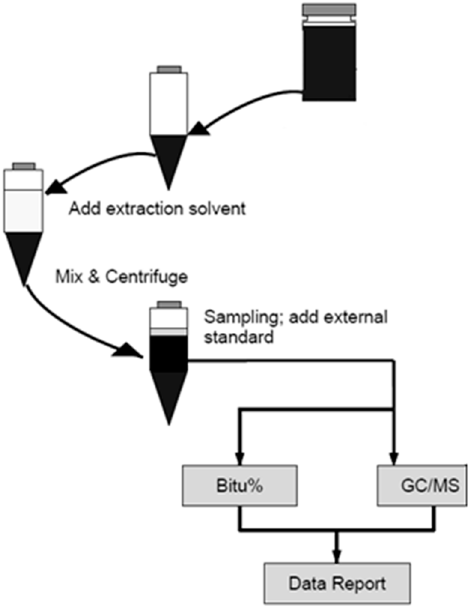
Figure 1. Experimental approach used for the thermodynamic properties determination.